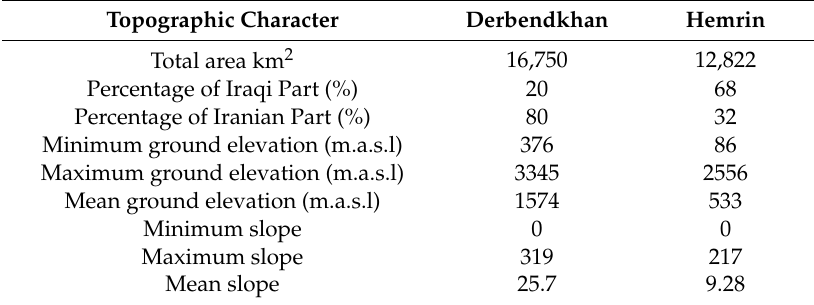
Figure 1. Map of the Diyala River Basin. Table 1. Topographic characteristics of the Derbendkhan and Hemrin Watersheds.